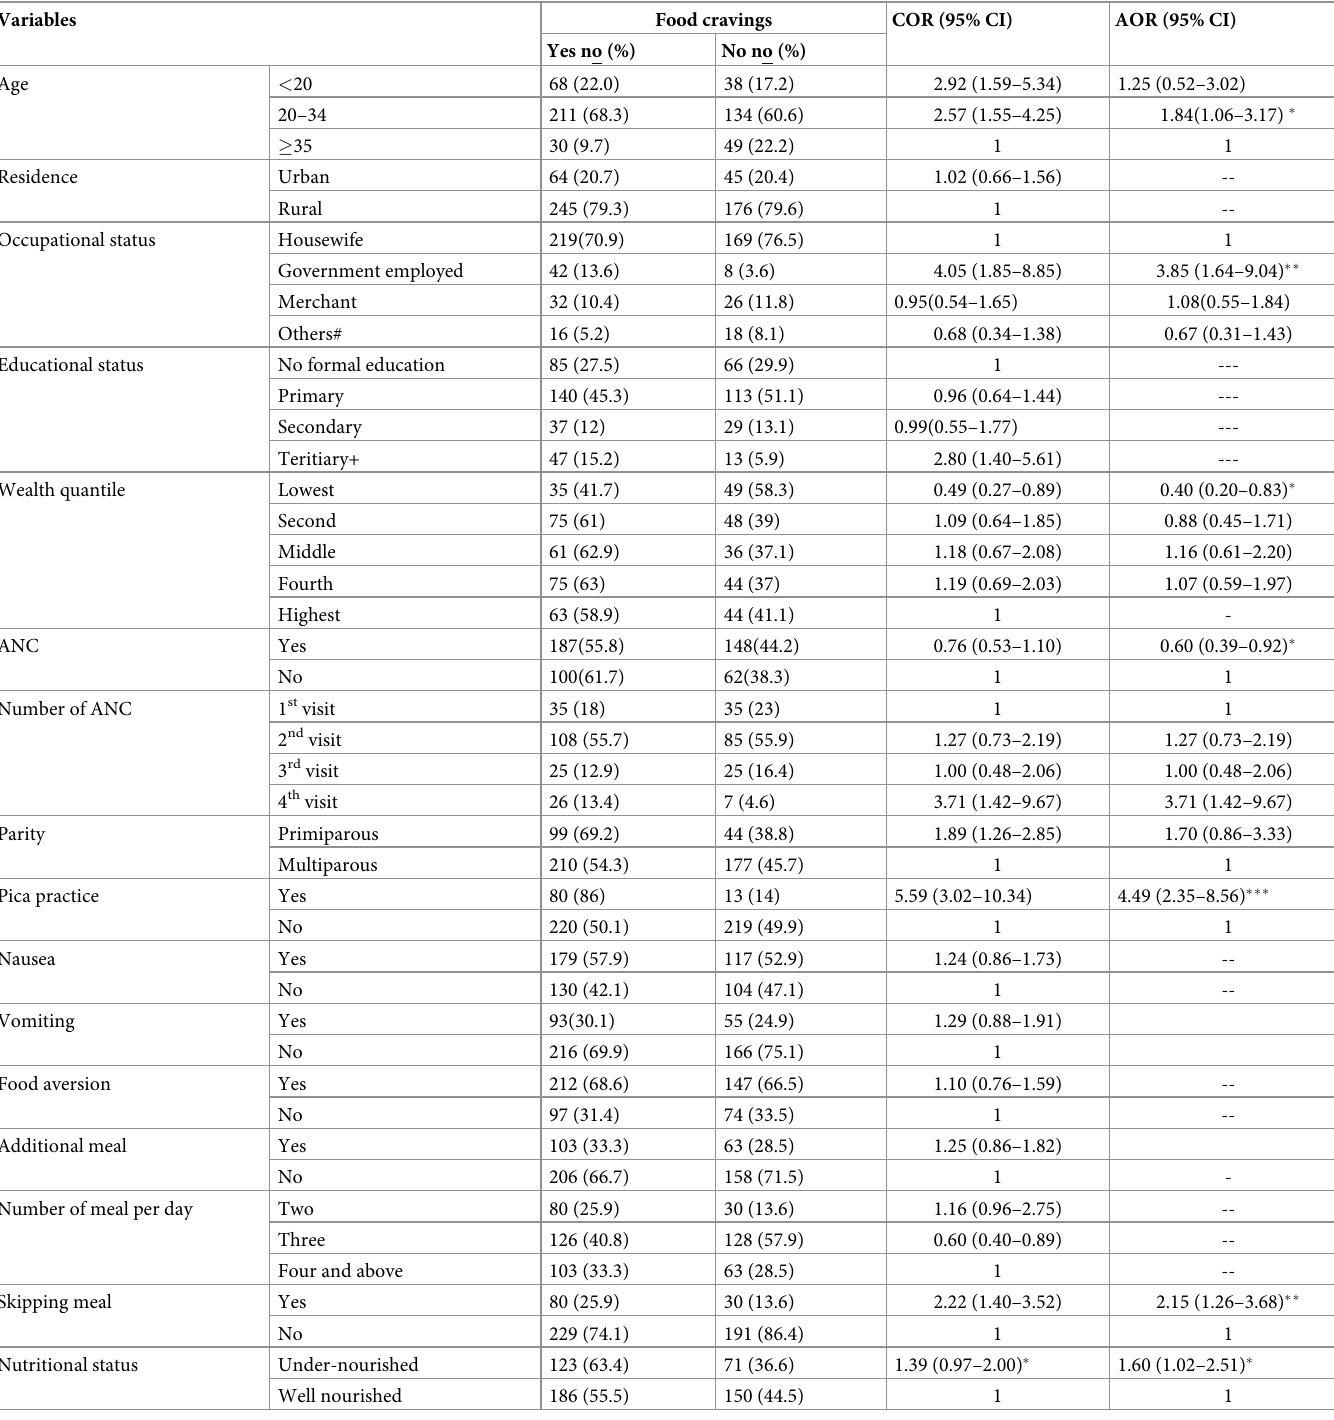
Table 4. Factors associated with food craving during pregnancy in Sidama Regional State, Southern Ethiopia,